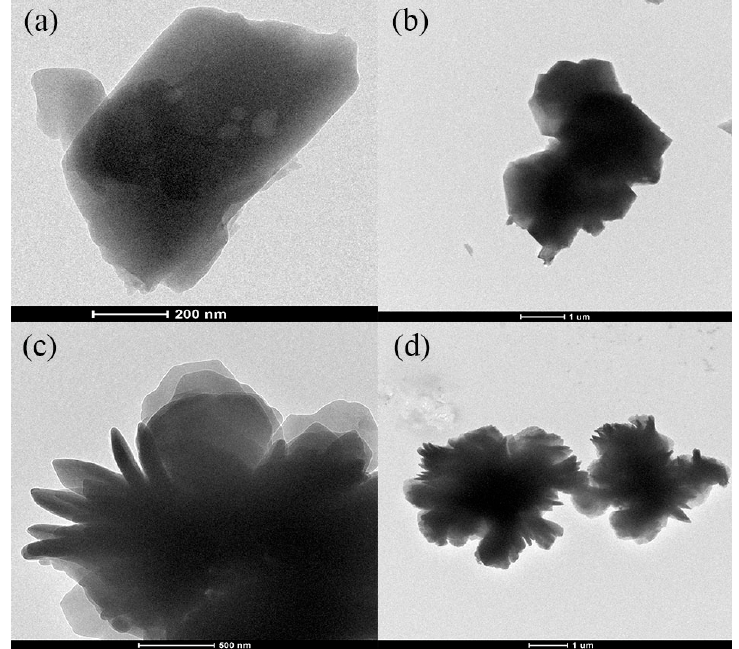
Figure 7. TEM images of PBT nanosheets synthesized with ( a , b ) an H 2 O 2 /BT molar ratio of 3.53 and an initial BT concentration of 58.25 mmol L − 1 , and ( c , d ) an I 2 /BT molar ratio of 1.5 and an initial BT concentration of 50 mmol L − 1 in ethanol at 25 °C for 24 h.